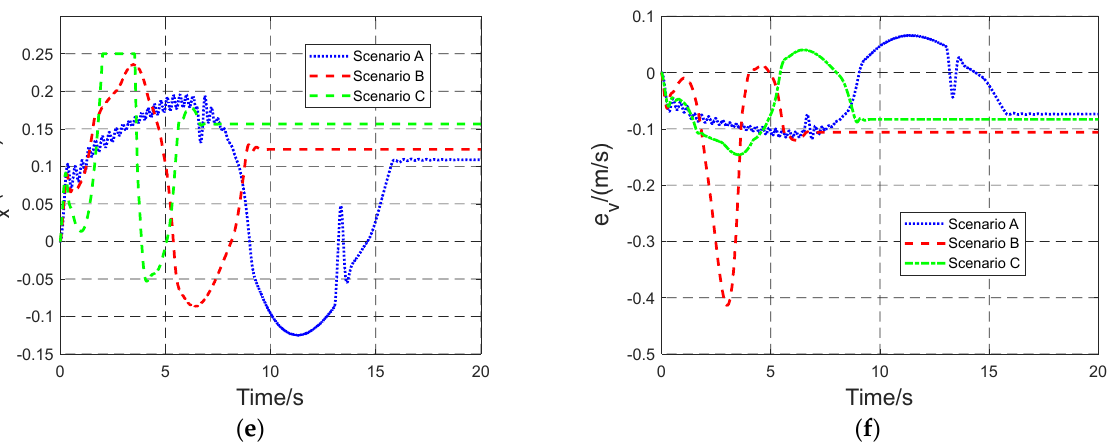
Figure 17. The simulation results of trajectory tracking: ( a ) Driving paths; ( b ) Lateral error; ( c ) The front-wheel steering angle; ( d ) The heading error; ( e ) Longitudinal acceleration; ( f ) Longitudinal velocity error. Table 7. RMSE of trajectory tracking error in the three scenarios.